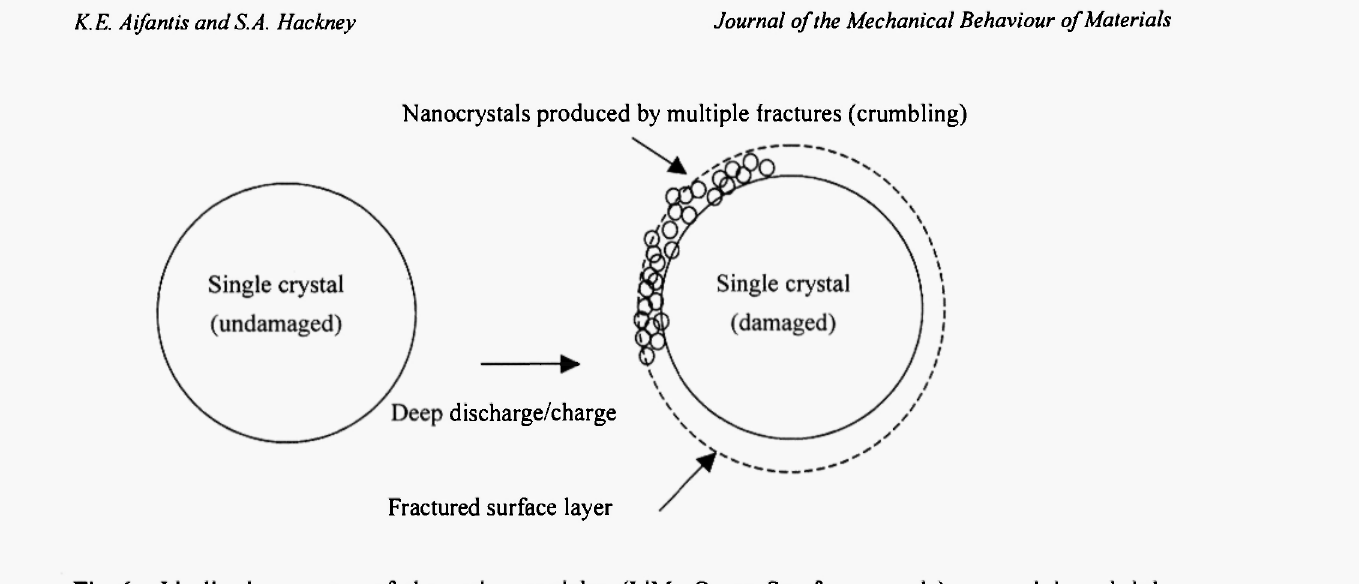
Fig. 6: Idealized geometry of the active particles (LiMn 2 0 4 or Sn, for example) encased in a brittle ceramic/glass or intermetallic matrix. The fractured zone due to nanocrack formation (damaged surface layer) is schematically shown.